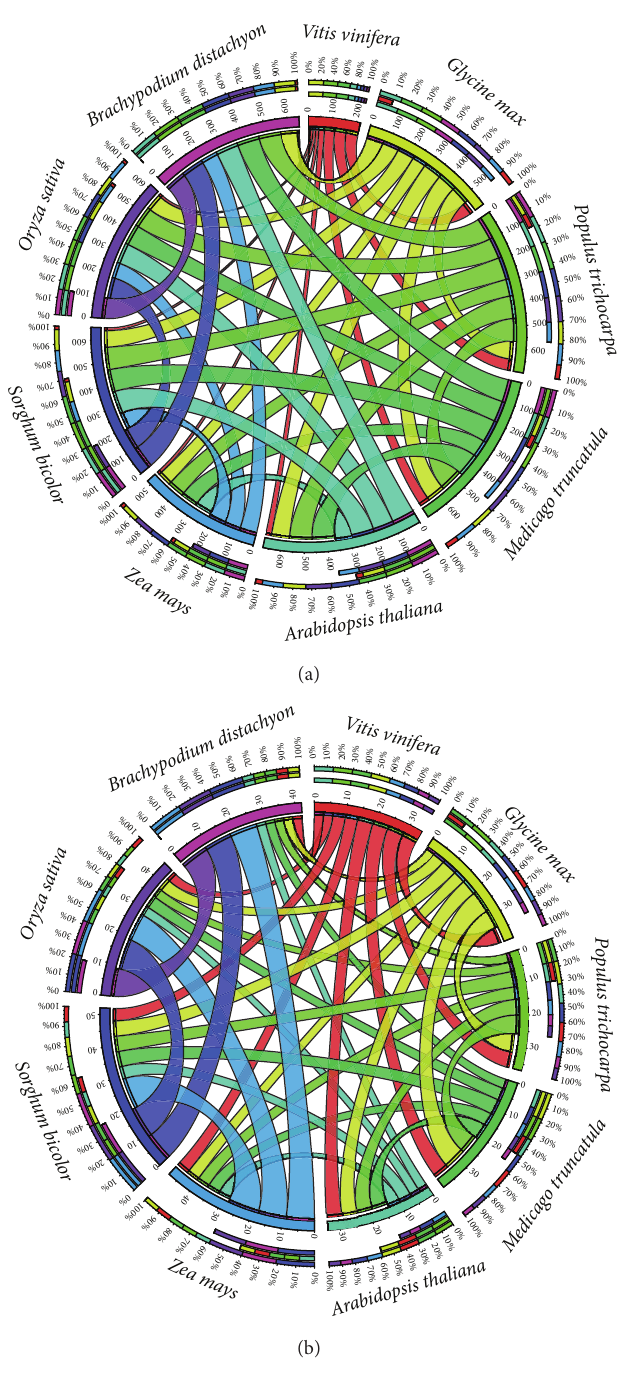
Figure 6: Orthologous pairs between different plant species for (a) PAL gene family and (b) POX A gene family. Each ribbon arising from a species (shown as clades) corresponds to the percentage of orthologous pairs with the destined species. PAL Vitis (red clade) was found to have the minimum orthology with other plant species. For POX A, monocots have high percentage of orthology, whereas Vitis and Arabidopsis were found to have the least orthology with